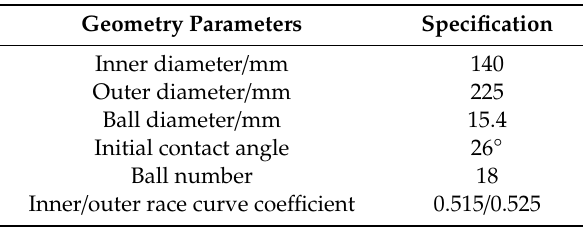
Figure 1. Configuration of ball bearing with under-race lubrication. Table 1. Geometry parameters of ball bearing.